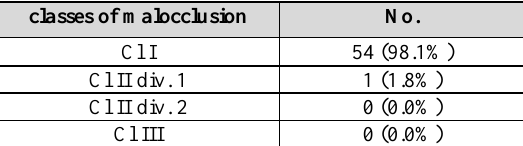
Table 3: Distribution of malposed canine in